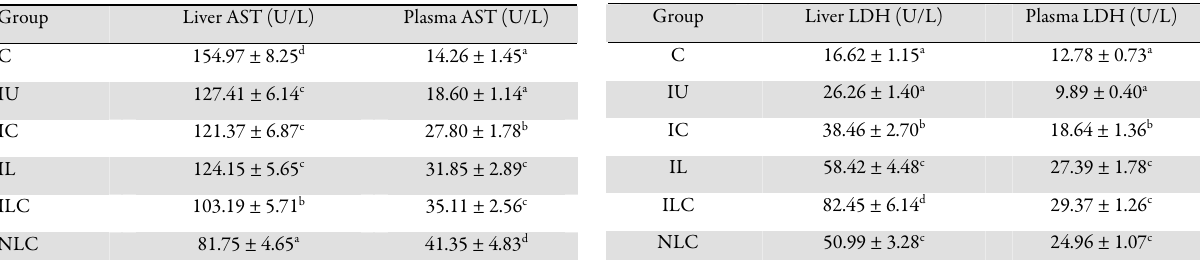
Table 6. The effect of lumefantrine and lumefantrine - copper complex on the specific activity of lactate dehydrogenase (LDH) in the liver and plasma